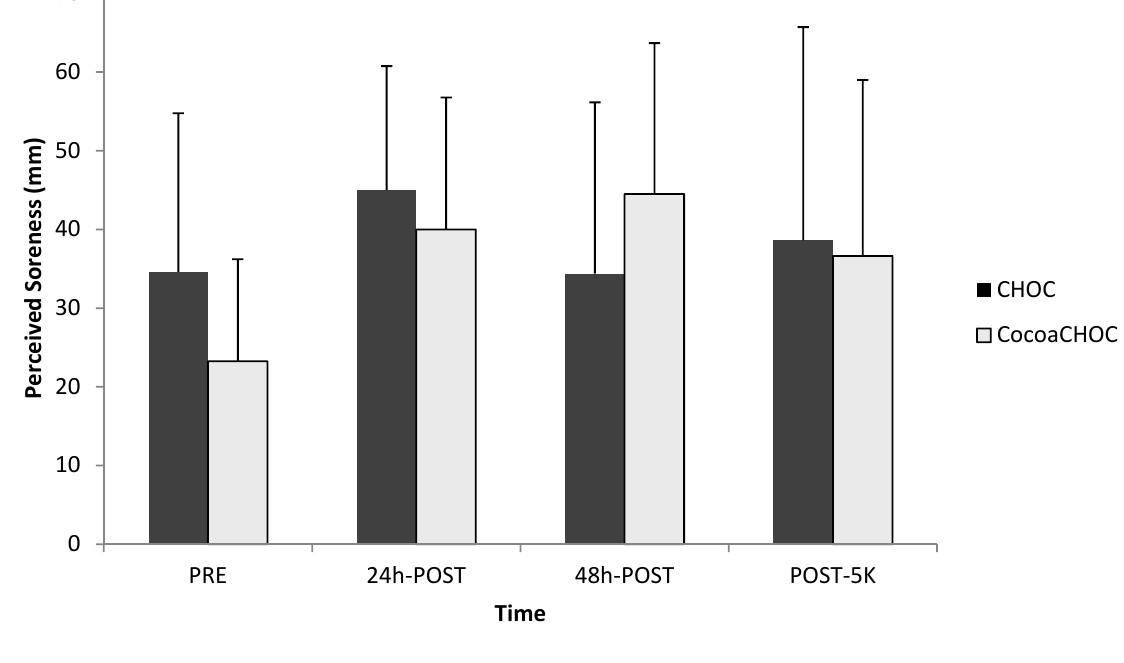
Figure 2. Mean ± SD perceived muscle soreness using the visual analog scale (VAS) at PRE, 24 h-POST, 48 h-POST, and POST-5K for each treatment beverage (CHOC,